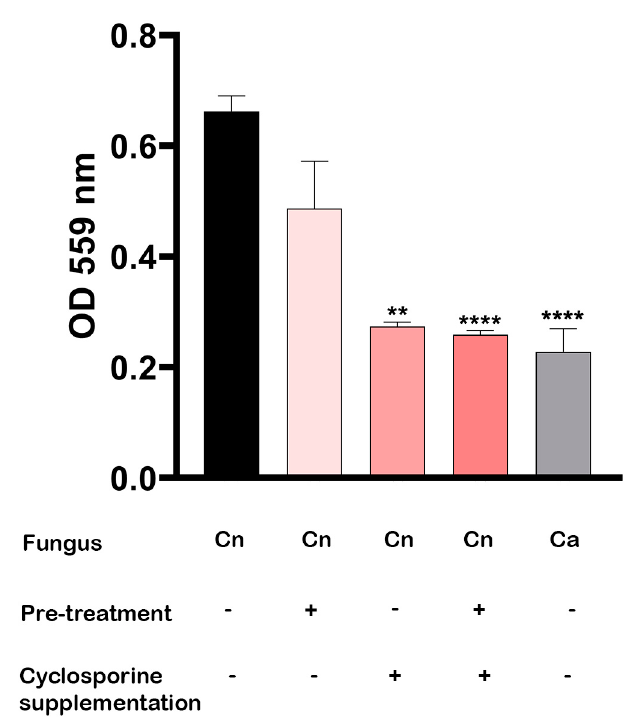
Figure 7. Urease production, measured according to optical density (OD) at 559 nm, of C. neoformans previously treated or not with 1 µ M cyclosporine in Christensen’s urea broth. C. albicans was used as negative control. ** p -value = 0.0038 and **** p -value < 0.00001; statistical significance was determined using Kruskal–Wallis test.